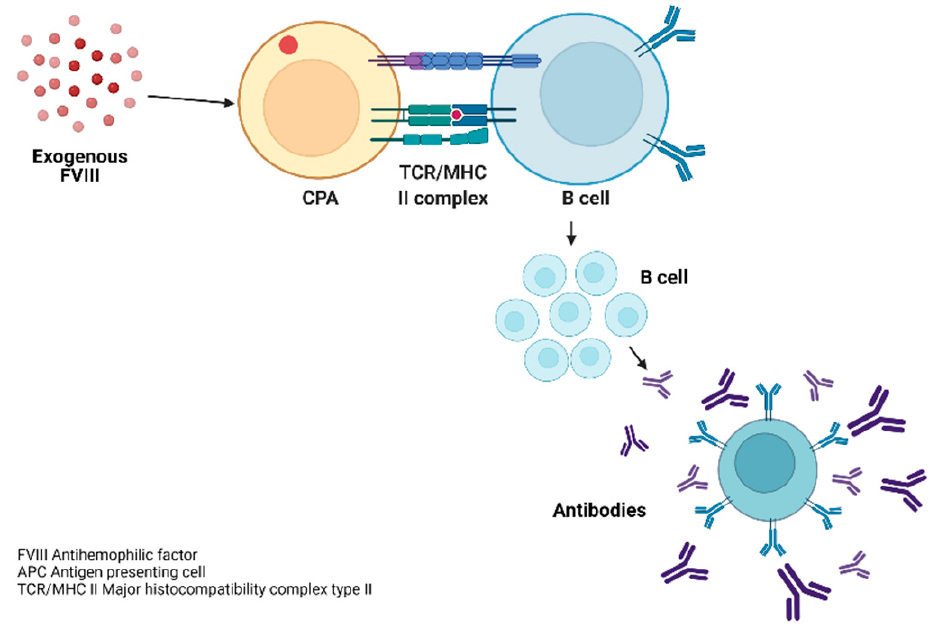
Figure 5. Development of inhibitors against exogenous FVIII. Note: Development of inhibitors against exogenous FVIII in patients with severe haemophilia A. Figure created by the main author using the BioRender tool.